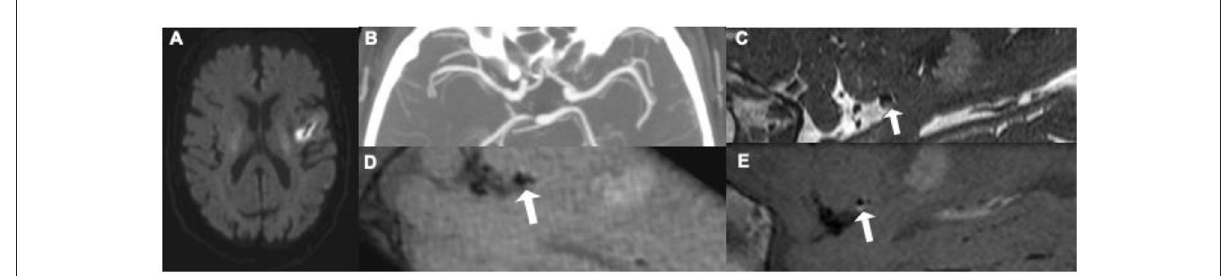
FIGURE3 This 62-year old patient presenting with an acute left middle cerebral artery (MCA) infarction on MR (A) had CT angiography [ (B) maximum intensity projection] at presentation without evidence of any significant stenosis. Initially thought to have an embolic stroke of undetermined source, he underwent an intracranial vessel wall MR where he was found to have a focal, eccentric T2 hyperintense [ (C) white arrow] enhancing [ (D) pre-contrast image, (E) post-contrast image, white arrow] plaque, in the distal M1 segment of the left MCA, thought to be the culprit